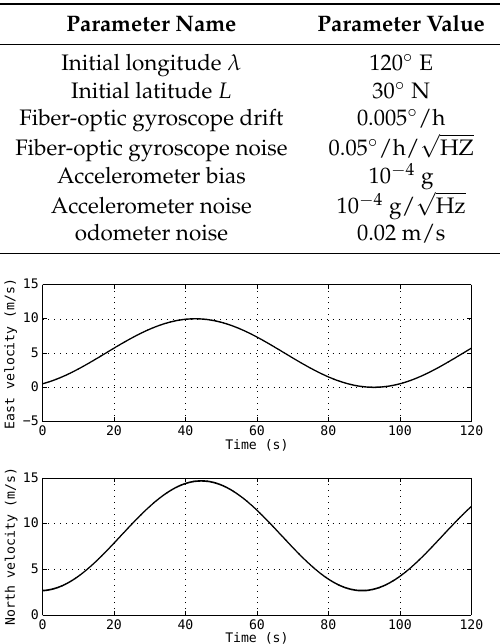
Figure 2. The true velocity profile of the simulation test.